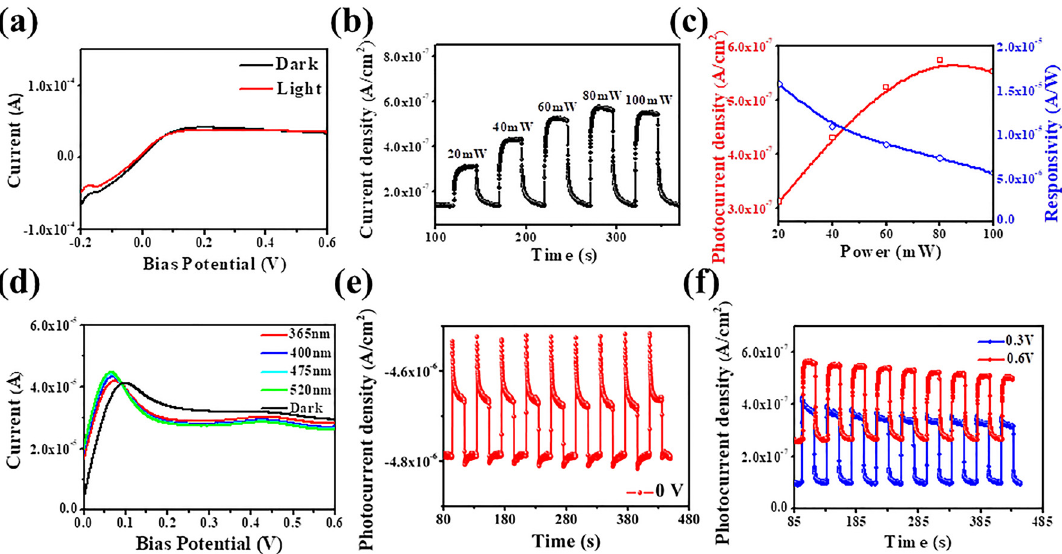
Figure 4: (a) Linear sweep voltammograms (LSV) tests of graphdiyne in 0.5 M KCl in the dark and light environments, respectively. (b)Photocurrentdensityofgraphdiyneinconditionofdifferentilluminationintensitiesin0.5MKCl.(c)MatchingB-splinecurveandcalculated photoelectric responsivity versus irradiance power intensity in 0.5 M KCl. (d) LSV measurements of graphdiyne in 0.5 M KCl in condition of variouswavelength.(e) Photocurrent densityin conditionof bias potentialof 0 V in0.5 MKCl, and(f) photocurrentdensityinconditionof